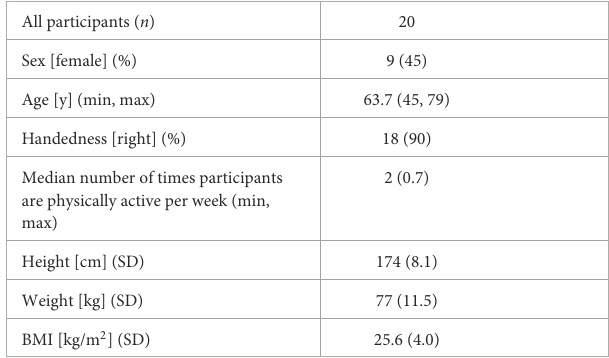
TABLE 1 Characteristics of